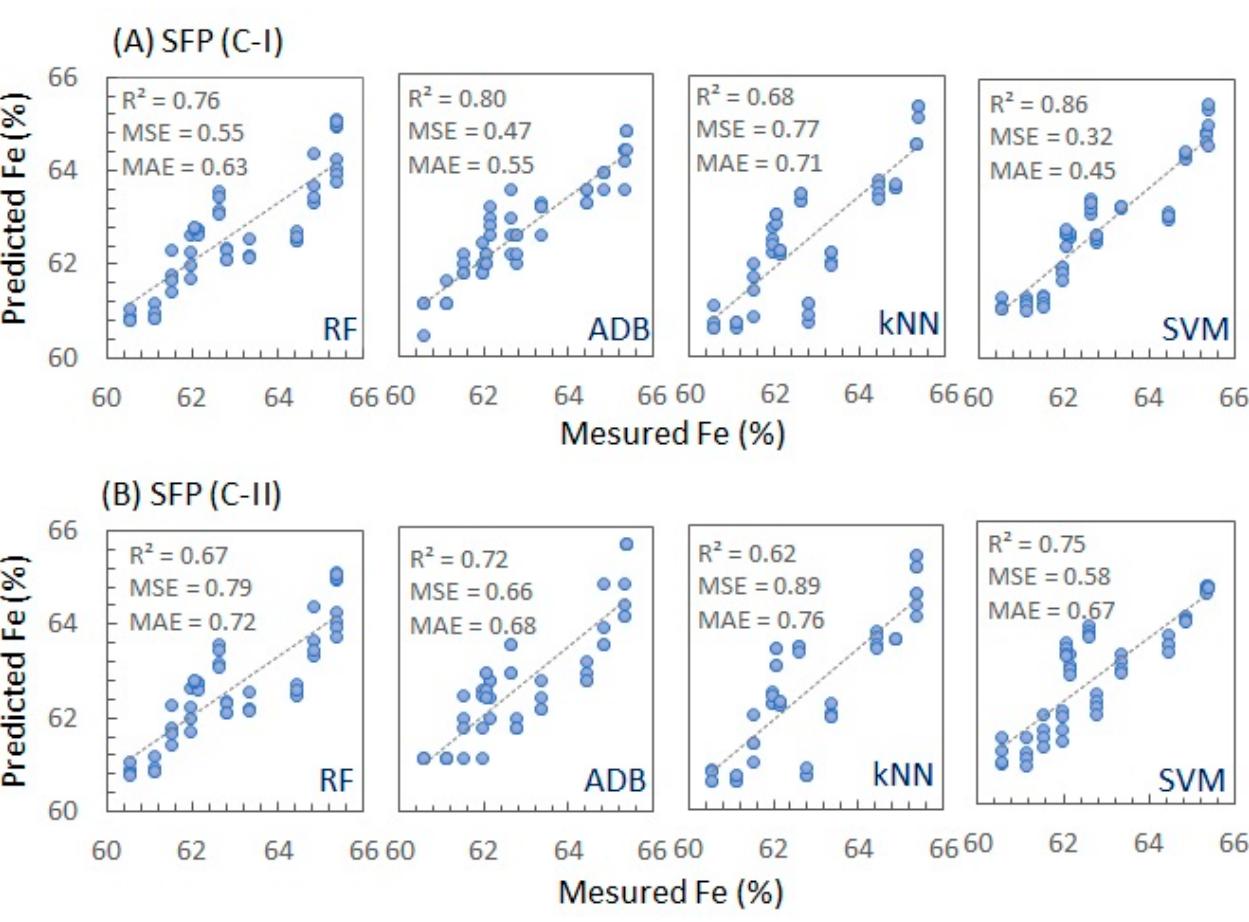
Figure 7. ( A ) Results of the models for estimating Fe tested with the SFP samples with the C-I spectra, showing better ADB and SVM performances. ( B ) Results of the models for estimating Fe tested with the SFP samples with the C-II spectra, showing that the models were not efficient in estimating the Fe content when reducing the spectrum to 400–1310 nm.